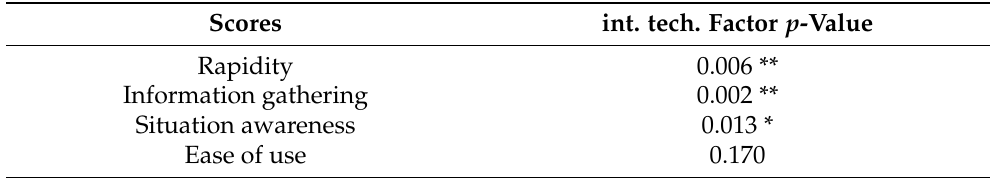
Table 5. Desktop application: between subjects—two-way ANOVA on quality factors scores with interaction technique and scenario